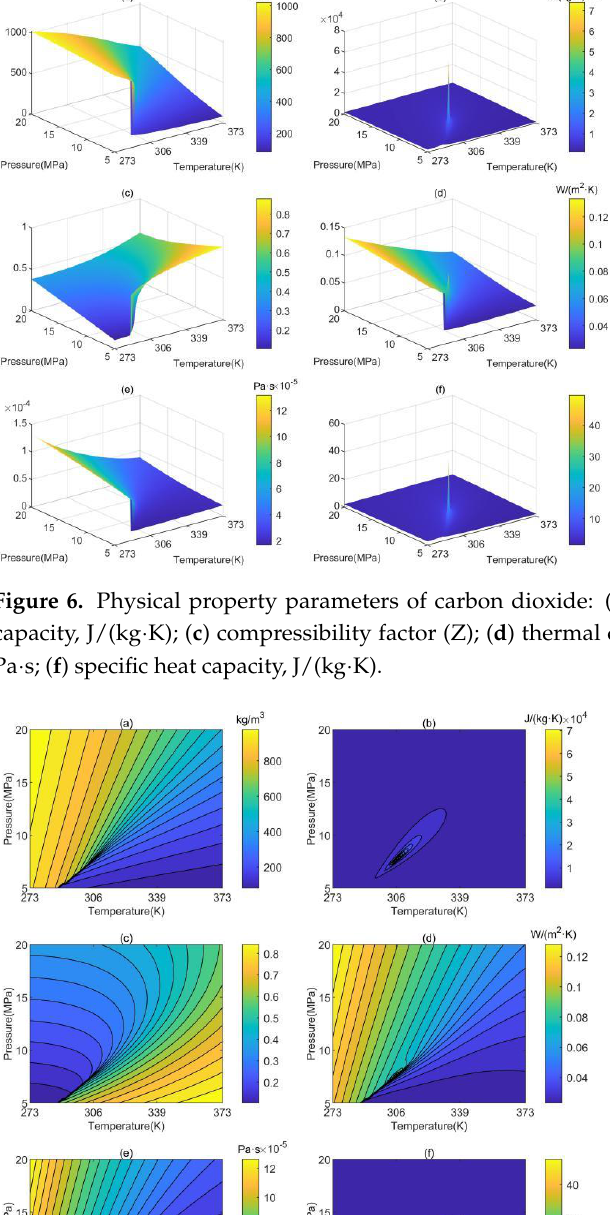
Figure 5. Thermophysical properties of methane at temperatures ranging from 273 to 373 K and pressures ranging from 5 to 20 MPa: ( a ) density, kg/m 3 ; ( b ) isobaric heat capacity, J/(kg·K); ( c ) com- pressibility factor (Z); ( d ) thermal conductivity, W/(m·K); ( e ) viscosity, Pa·s; ( f ) specific heat capacity, J/(kg·K).